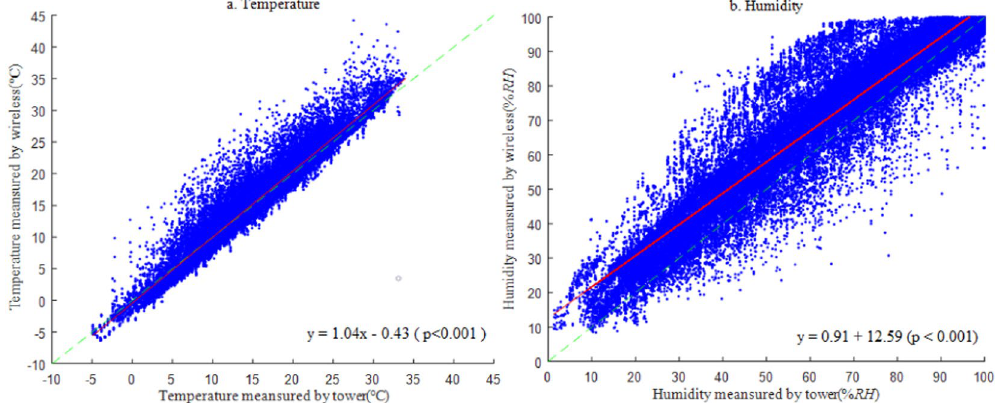
Figure 1. Overall accuracy evaluation of temperature ( a ) and humidity ( b ) observed by the wireless sensor. (n = 39796 and 44227 points for temperature and humidity,